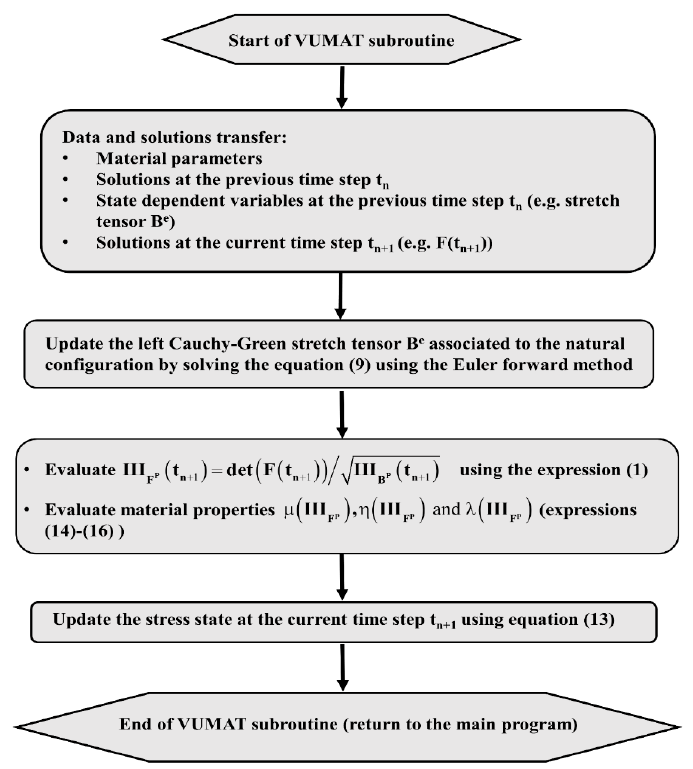
Figure 15. The flowchart of VUMAT subroutine.